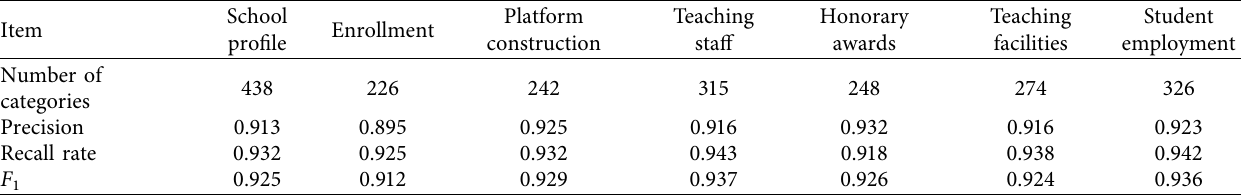
Table 3: Statistical results of educational information classification based on the classification model proposed in this